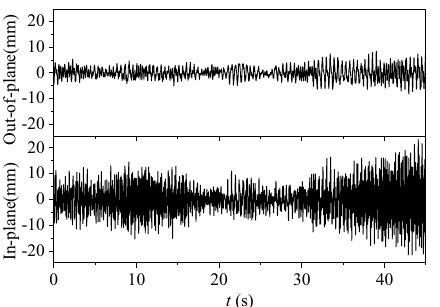
Figure 11. The time histories of fluctuating wind-induced displacement for measurement point D 2 at a velocity of 6 m/s (15° wind